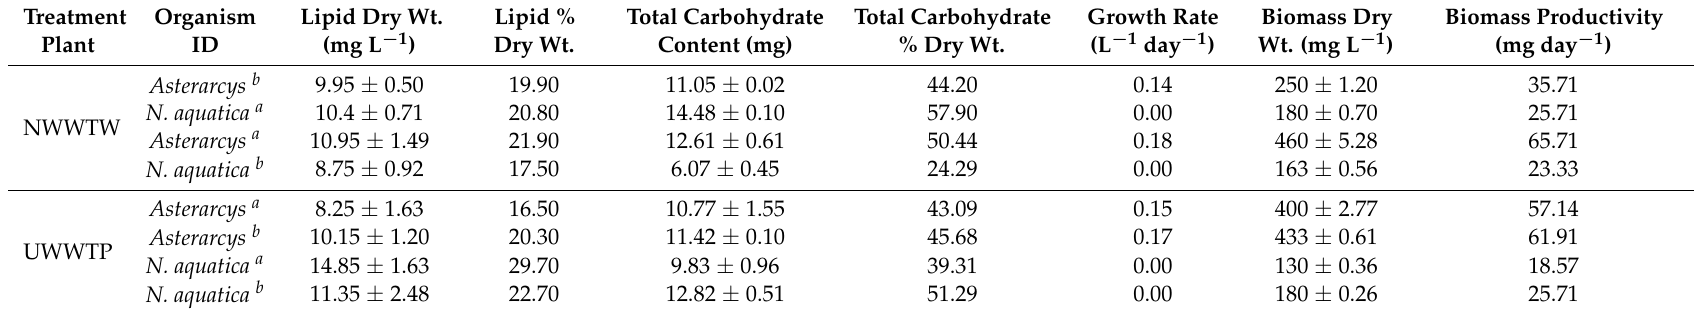
Table 2. Growth kinetics and metabolite accumulation in microalgae cultivated in sterilized and raw treated wastewater effluent.